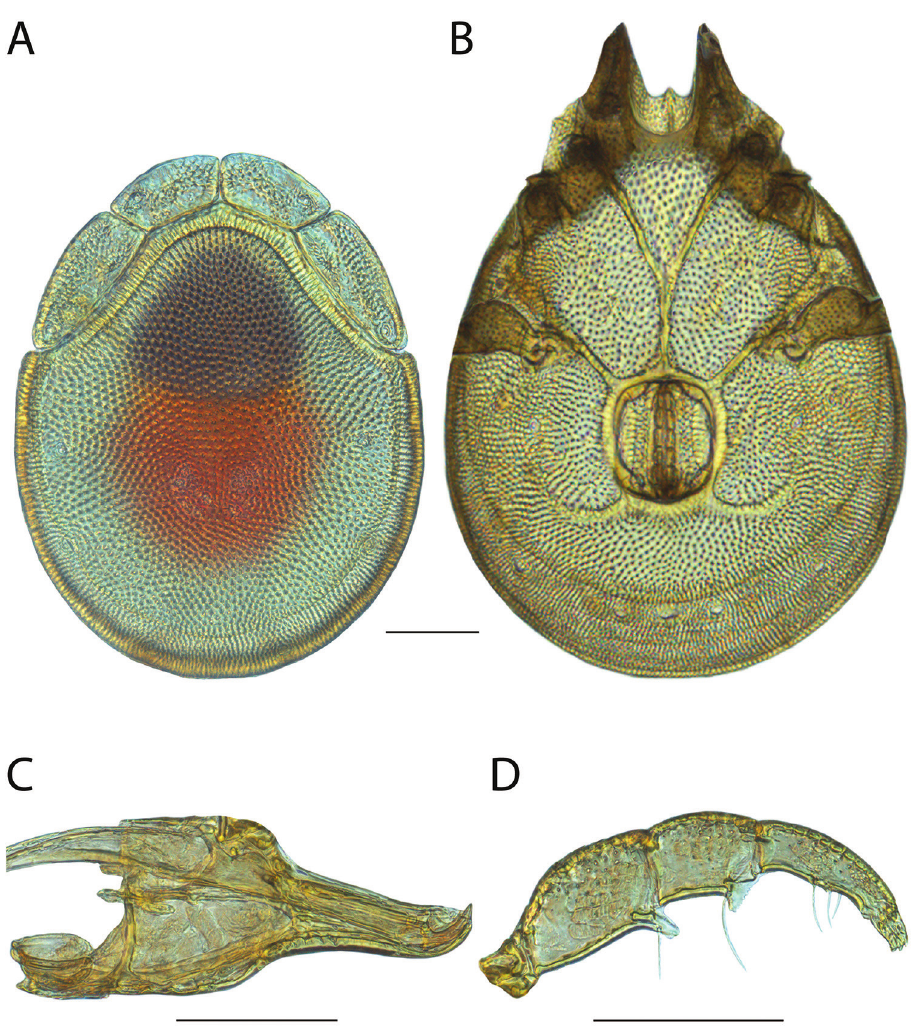
Figure 119. Torrenticola kringi sp. n. male: A dorsal plates B venter (legs removed) C subcapitulum D pedipalp (setae not accurately depicted). Scale = 100